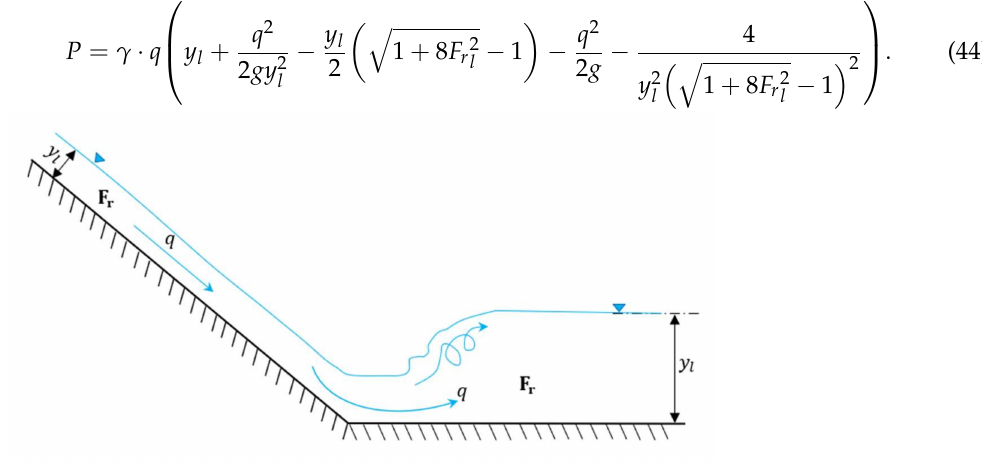
Figure 9. Flow conditions of a hydraulic jump [4].